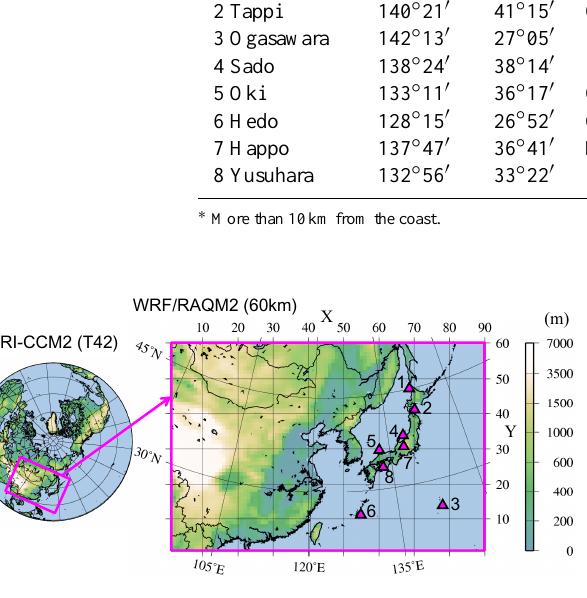
Fig. 3. Modeling domains showing terrestrial elevation (m) and the EANET monitoring sites (triangles 1 through 8). Locations of the EANET stations are given in Table